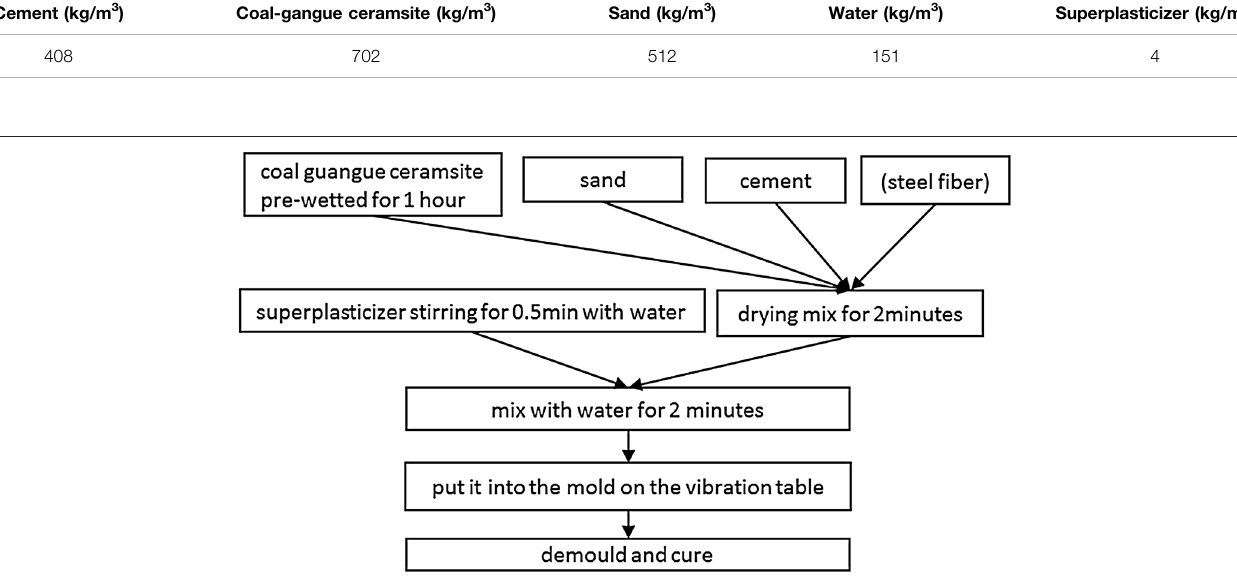
Frontiers in Materials |